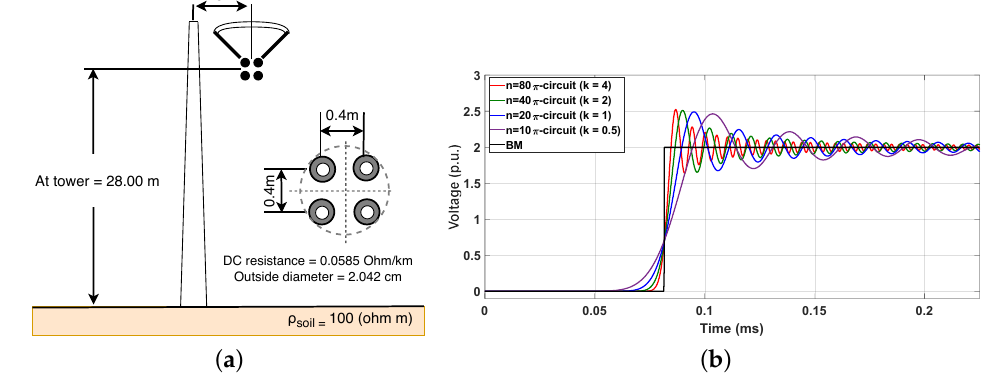
Figure 1. ( a ) Layout of the single-phase TL; ( b ) Transient responses obtained by the traditional LPM and